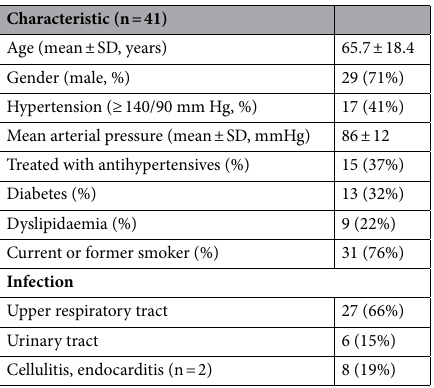
Table 1. Participant characteristics where 1st CRP > 100 and 2nd CRP < 100 mg/L.